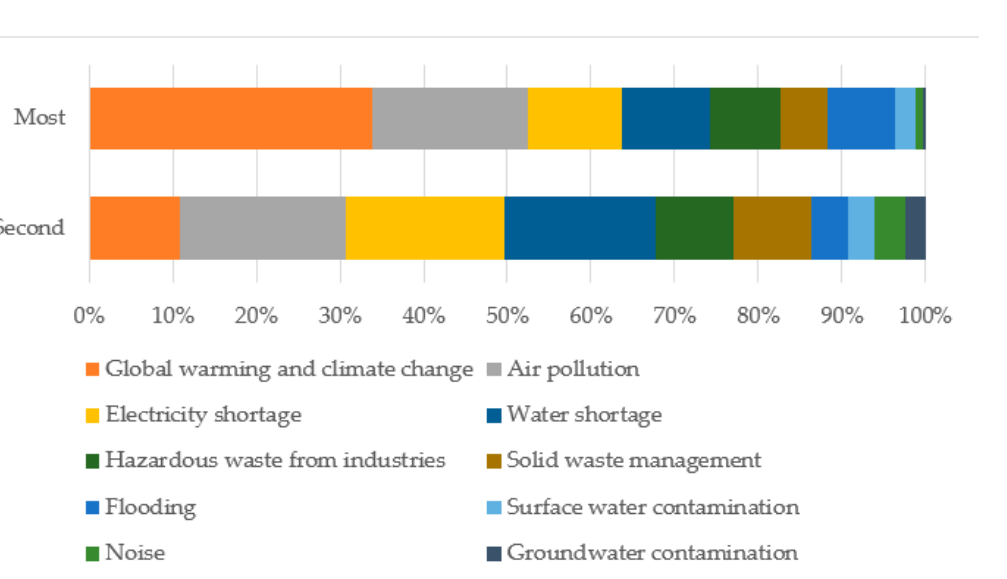
Table 5. Marginal willingness to pay (WTP) for renewable energy.